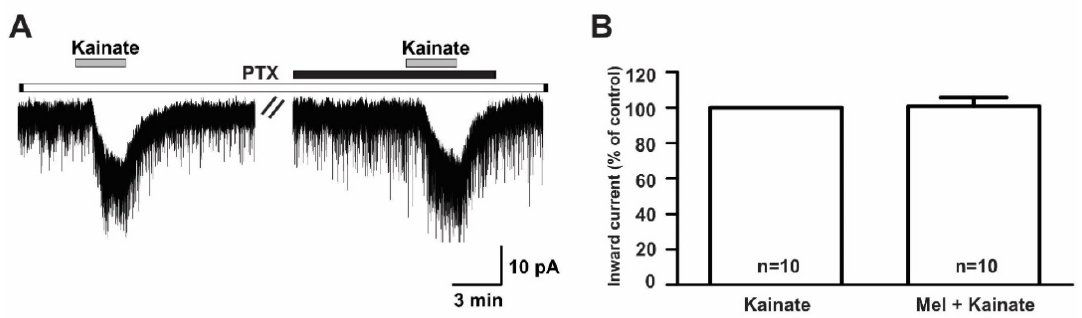
Figure 8. The melatonin e ff ect on kainate-induced responses was blocked by the presence of pertussis toxin, a G-protein-coupled receptor blocker. ( A ) A representative trace showing the blockade of 10 µ M melatonin action on the kainate (10 µ M)-induced response in GnRH neurons in brain slices incubated with pertussis toxin for more than 8 h. The black bar represents the duration of melatonin application. ( B ) Bar graph showing the mean relative percentage of inward current induced by kainate in the presence of melatonin compared to kainate alone, following pre-incubation with pertussis toxin ( p > 0.05; paired t -test). n , the number of neurons tested; Mel, melatonin.